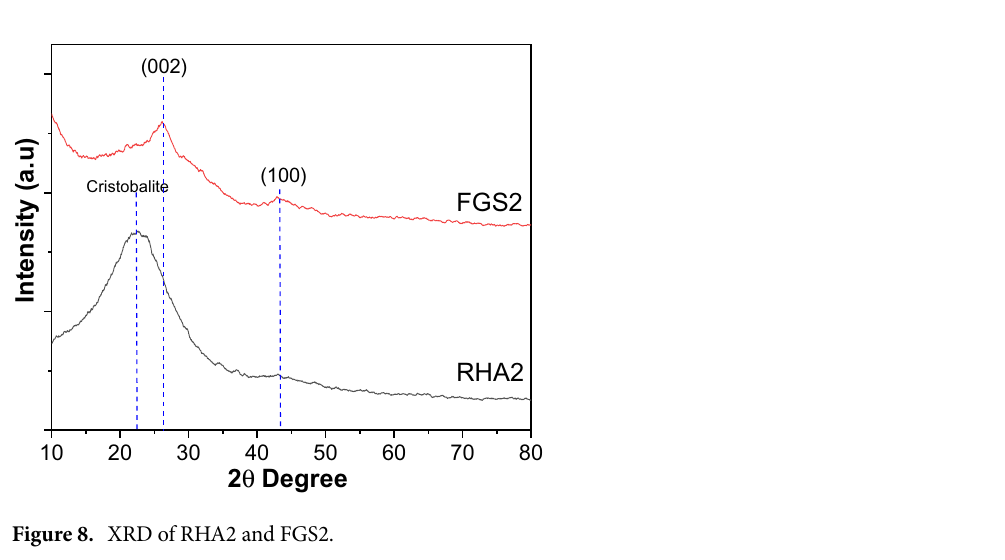
Figure 7. N 2 adsorption isotherms of functionalized GO/SiO 2 nanocomposites.